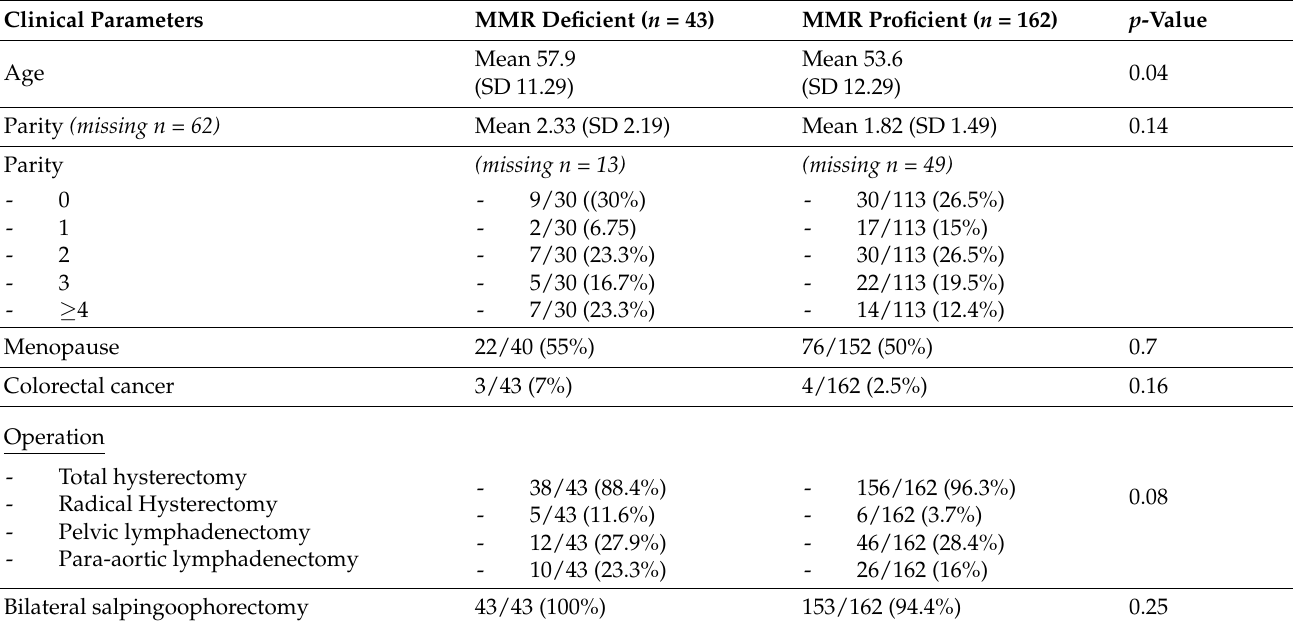
Table 2. MMR status in association with clinical